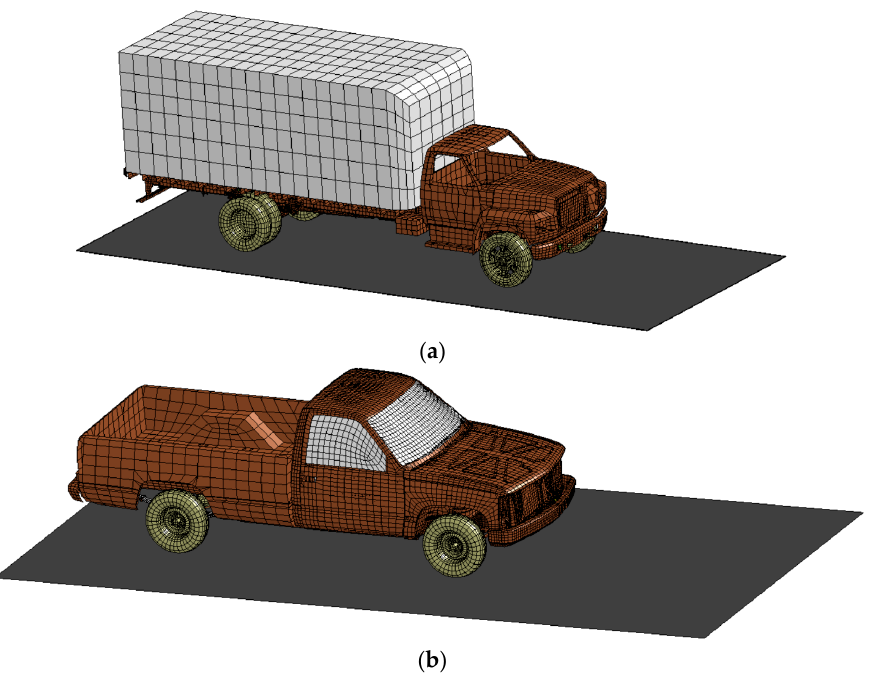
Figure 3. Modeling of the vehicles (NCAC [34]): ( a ) Ford Single Unit Truck (SUT) and ( b ) Chevrolet C2500 Pickup.